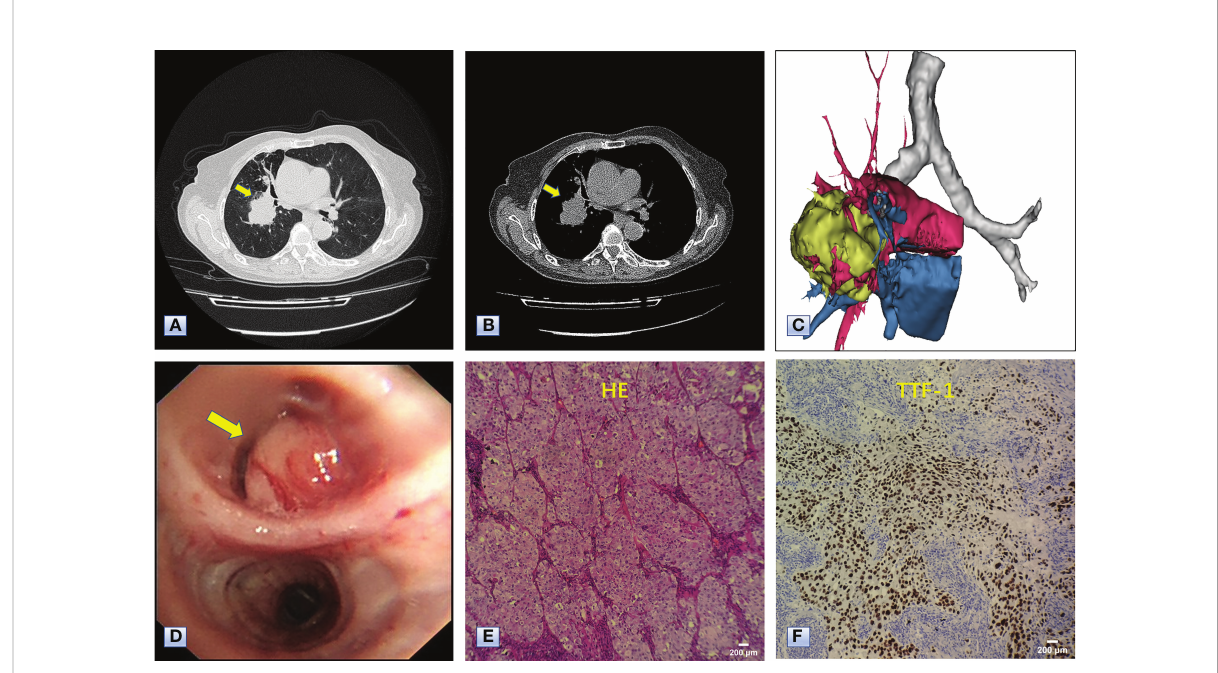
FIGURE 3 Chest CT, bronchoscopy and pathologic examination of the mass in the right lower lobe. (A, B) Axial images of chest CT, revealing a mass approximately 5 cm in diameter in the right lower lobe adjacent to the hilum (arrows). (C) 3D reconstruction revealing that the mass was adjacent to the hilum and invaded the surrounding vessels, indicating the mass was a malignancy. (D) Bronchoscopy results, showing a neoplasm (arrow) in the bronchus of the right basal segment. (E) Hematoxylin-eosin staining showing the complete absence of normal alveolar structure, replaced by growing cancer cells with enlarged nuclei and cloudy cytoplasm. (F) Immunohistochemical staining with antibodies to TTF-1, indicating that the tumor cells positively expressed TTF-1. The combined results of HE staining and immunohistochemistry indicated that the mass in the right lower lobe was an